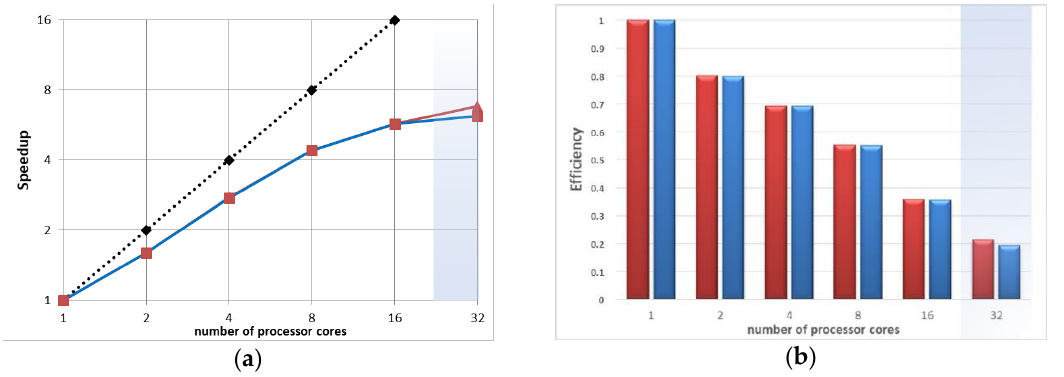
Figure 7. Experimental performance measured on platform A as a function of the number of engaged threads/cores ( N ) , for both static (blue) and dynamic (red) scheduling strategies: ( a ) Speedup factor S ( N ) (continuous lines) and ideal speedup (dashed line) shown as a reference; ( b ) efficiency ε ( N ) . Shaded areas in the graphs corresponds to the number of additional threads provided by the hyper-threading technology.